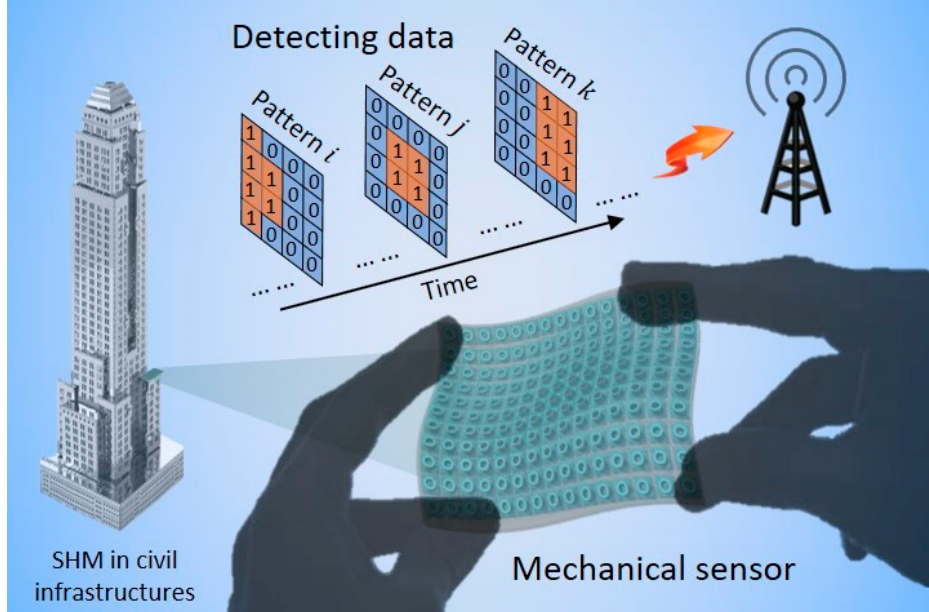
Figure 4. Potential application of the mechanical sensors for measuring structural conditions for SHM in civil infrastructures.